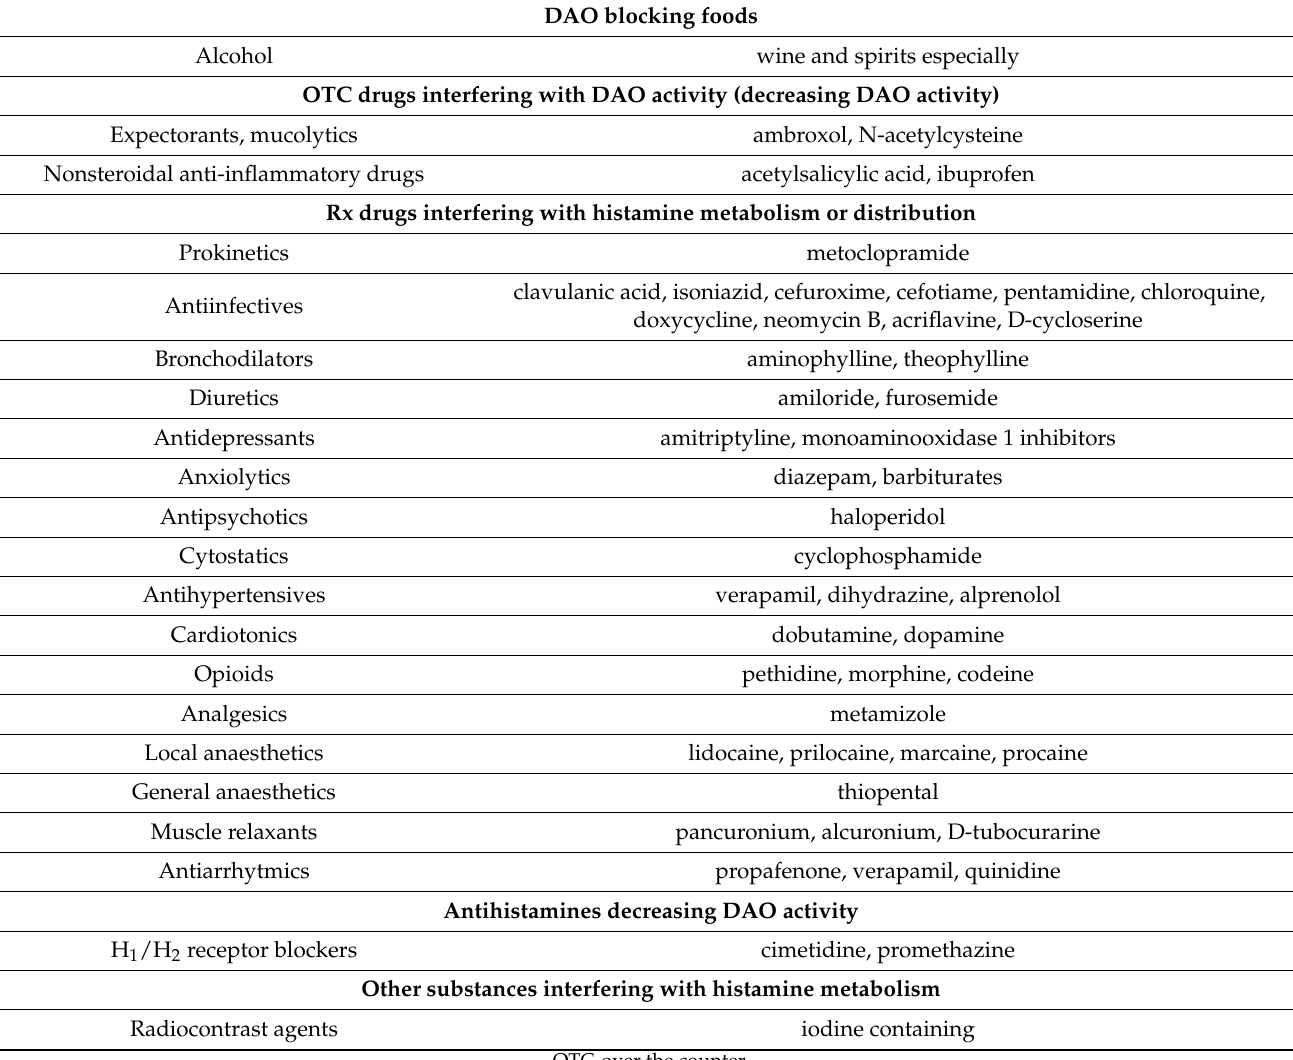
Table 2. Drugs and substances with possible effects on the metabolism and the distribution of histamine in the organism, which encompass decreasing DAO activity. Adapted according to